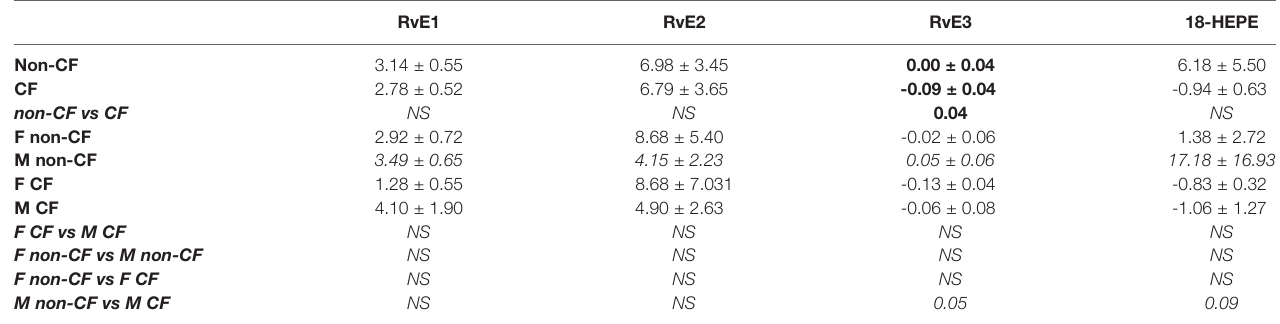
TABLE 4 | Eicosapentaenoic (EPA) metabolites